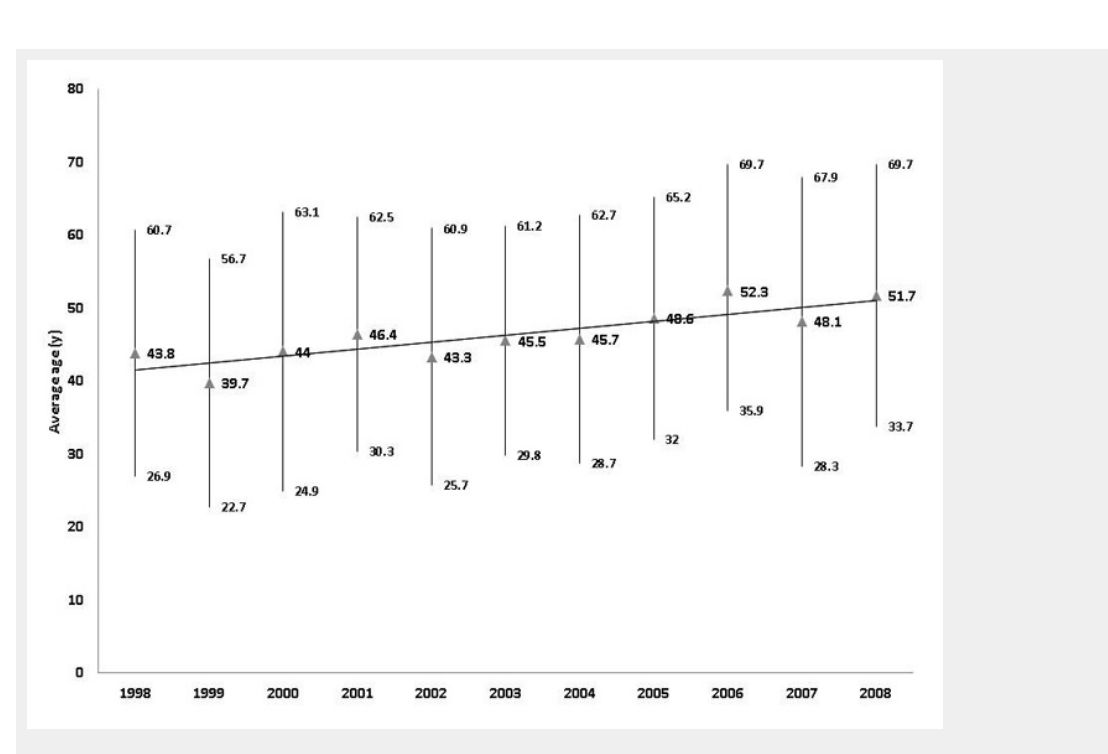
Figure 1 Number of deceased donors in Switzerland, per year.